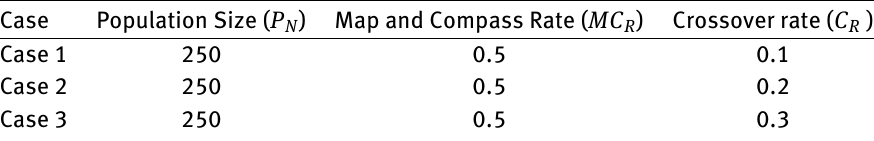
Table 4: Modified BPIO Parameter